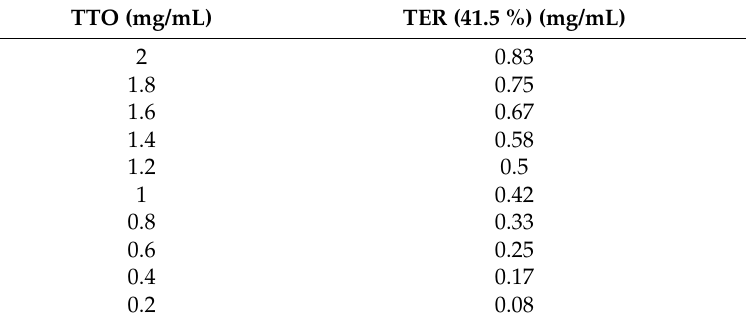
Table 5. Concentrations of tea tree oil (TTO) and Terpinen-4-ol (TER) used in the study. TER concentrations were calculated according to its presence in the used TTO